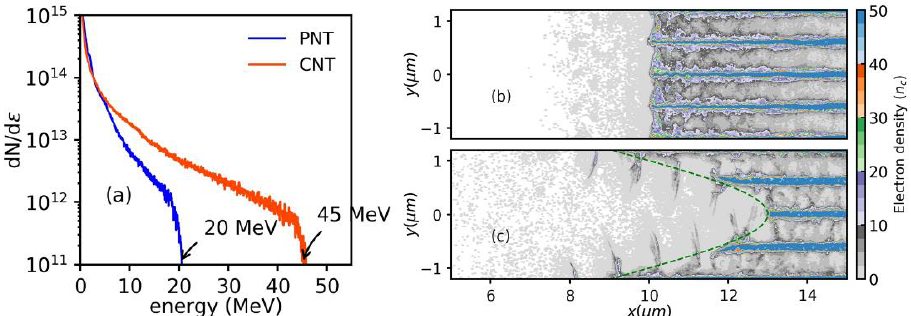
Figure 6. ( a ) Energy spectra of protons at the end of simulation. ( b , c ) Density of electrons at t = 22 T 0 . The fill factor ( f =